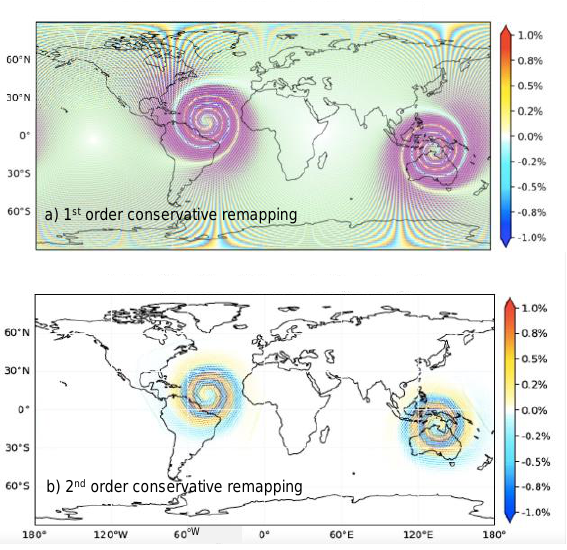
Figure 18. Misfit (%) for the ( a ) first-order and ( b ) second-order conservative remapping (both with FRACAREA normalisation) of the vortex function from the low-resolution icosahedral grid icos to the high-resolution icosahedral grid icoh with YAC.